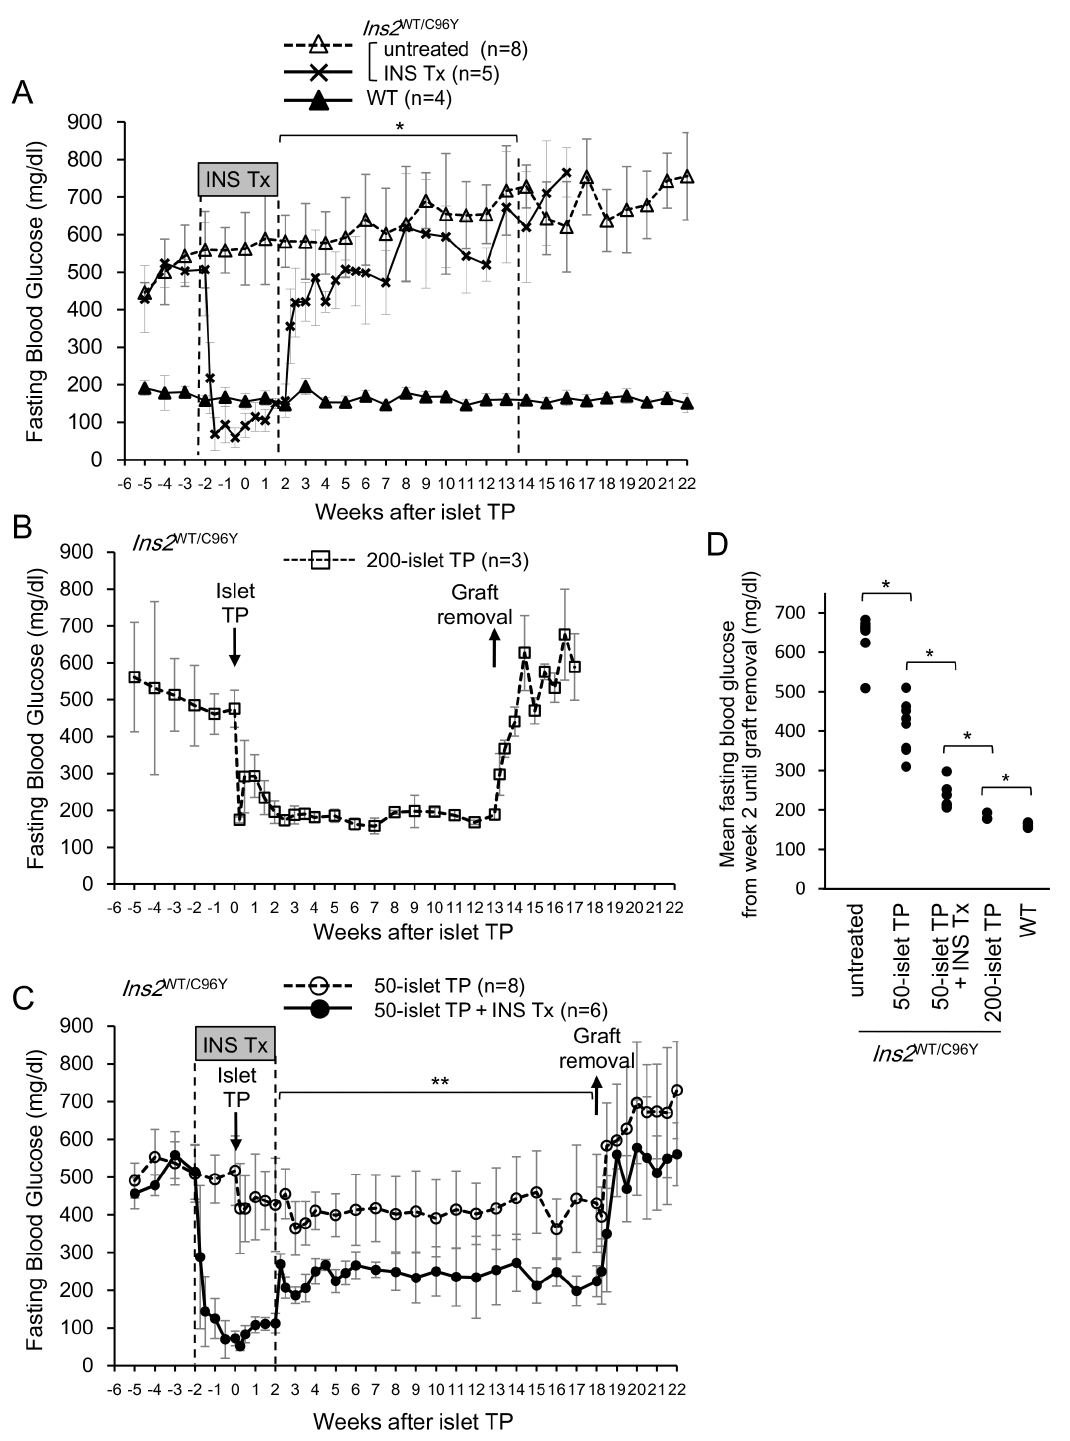
Figure 2. Insulin treatment improved islet transplantation outcomes. (A–C) Fasting blood glucose levels of Akita ( Ins2 WT/C96Y , untreated) mice (broken line with open triangles), the INS Tx group (solid line with crosses), and C57BL/6 WT mice (solid line with closed triangles). (A) Insulin implants were inserted at week 2 2 and removed at week 2. There were significant differences between the INS-treated and INS-untreated groups from 2 to 14 weeks (* p , 0.05, ANOVA). (B) Fasting blood glucose levels in the 200-islet TP group (broken line with open squares). Two hundred islets were transplanted at week 0, and removed at week 13. (C) Fasting blood glucose levels of the 50-islet group (broken line with open circles) and 50- islet TP + INS Tx group (solid line with closed circles). Insulin treatment significantly lowered the blood glucose levels (** p , 0.01, ANOVA). (D) Average fasting blood glucose levels of individual mice in each group from the time of insulin implant removal (week 2) until graft removal. Each dot represents the mean values in 1 mouse. The 50-islet TP + INS Tx group had significantly lower average fasting blood glucose levels than the 50-islet TP group (* p , 0.05, two-tailed unpaired Student’s t- test).